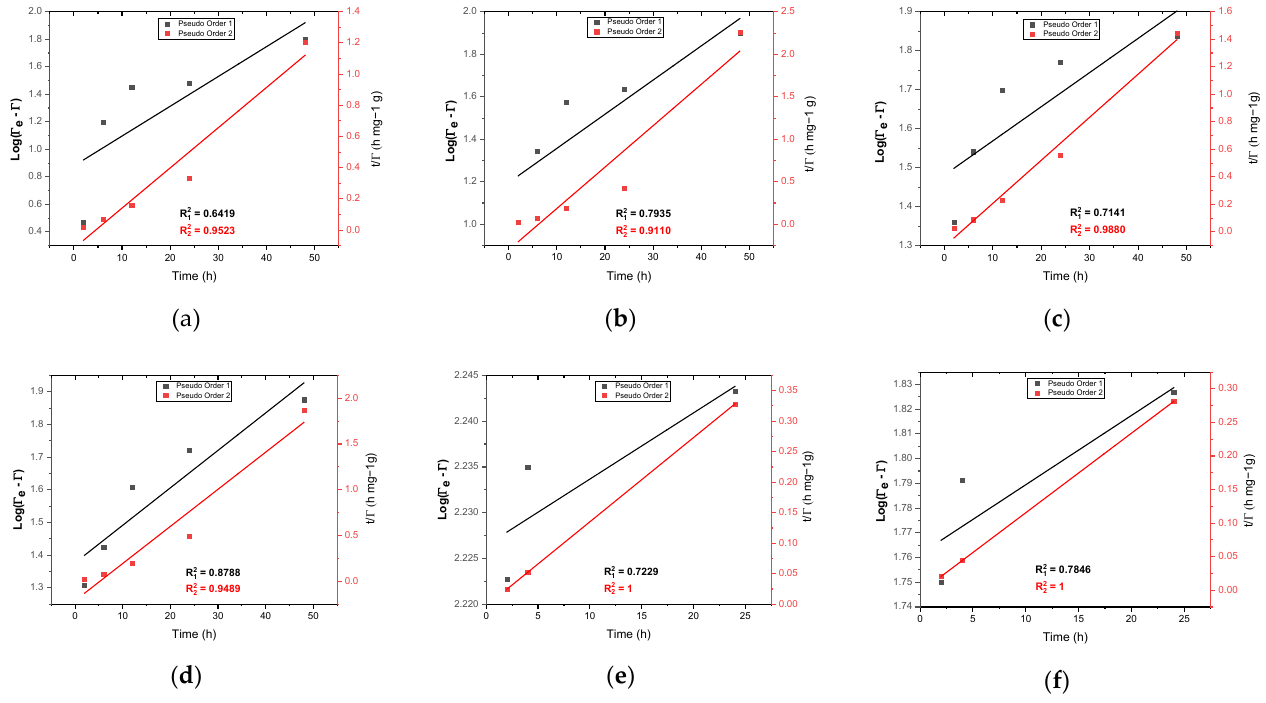
Figure 7. ( a ) Kinetics of desorption (%) of atrazine with C = 25 mg/L from natural Brari clay; ( b ) kinetics of desorption (%) of atrazine with C = 25 mg/L from natural Dardha clay; ( c ) kinetics of desorption (%) of benalaxyl with C = 25 mg/L from natural Brari clay; ( d ) kinetics of desorption (%) of benalaxyl with C = 25 mg/L from natural Dardha clay; ( e ) kinetics of desorption (%) of dimethoate with C = 25 mg/L from natural Brari clay; and ( f ) kinetics of desorption (%) of methomyl with C = 25 mg/L from natural Brari clay. They present the kinetics of desorption (%) of atrazine, benalaxyl, dimethoate, and methomyl with C = 25 mg/L from natural Brari and Dardha clays.